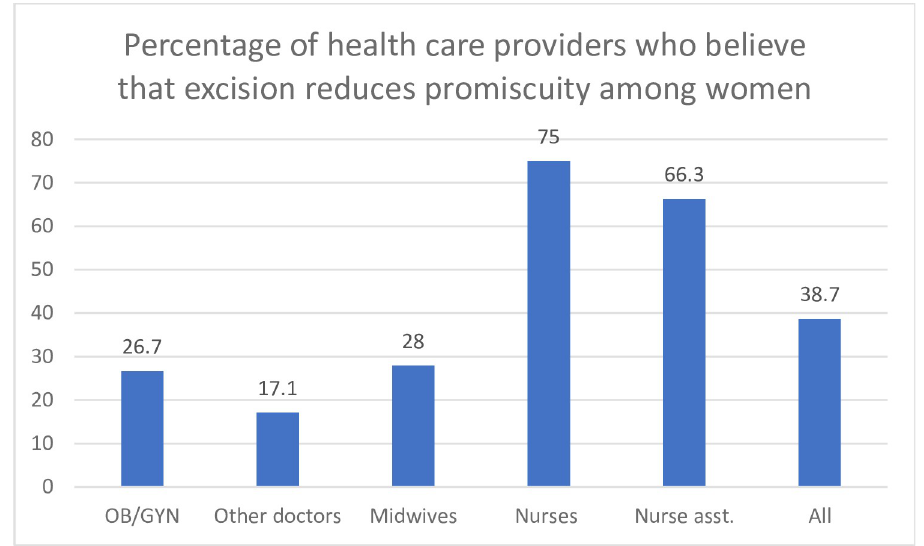
Fig 1. Percentage of health care providers who believe that excision reduces promiscuity among women.